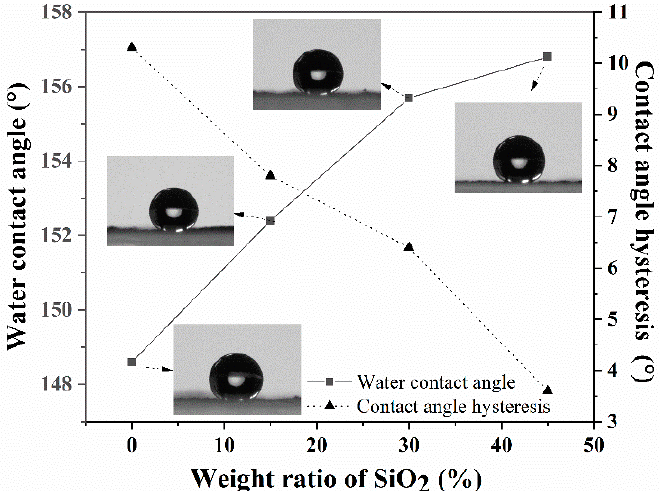
Figure 1. Relation between weight ratio of SiO 2 , water contact angles, and contact angle hysteresis. The mass fraction of CNTs in each of these coatings was 30%. The inserts were 5 µL water drop profiles on the surface of the composite coatings.